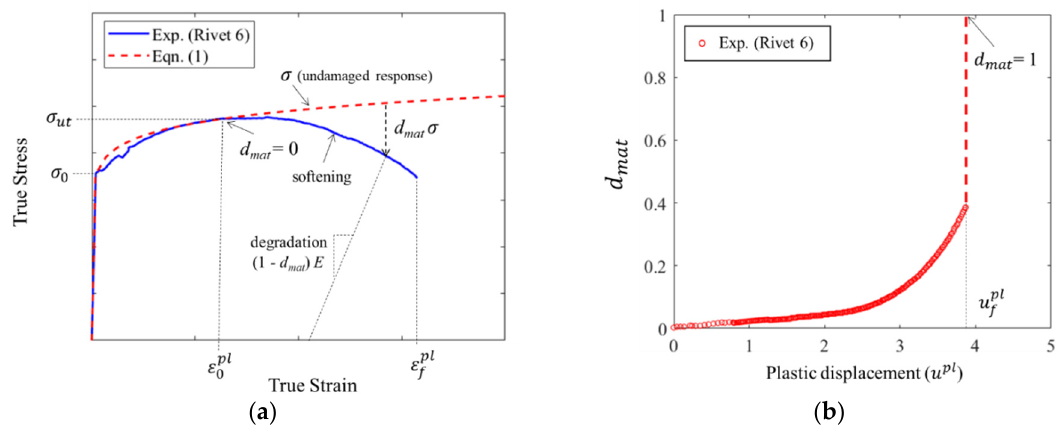
Figure 5. ( a ) Schematic representation of damage model and ( b ) evolution of damage variable vs. plastic displacement for rivet